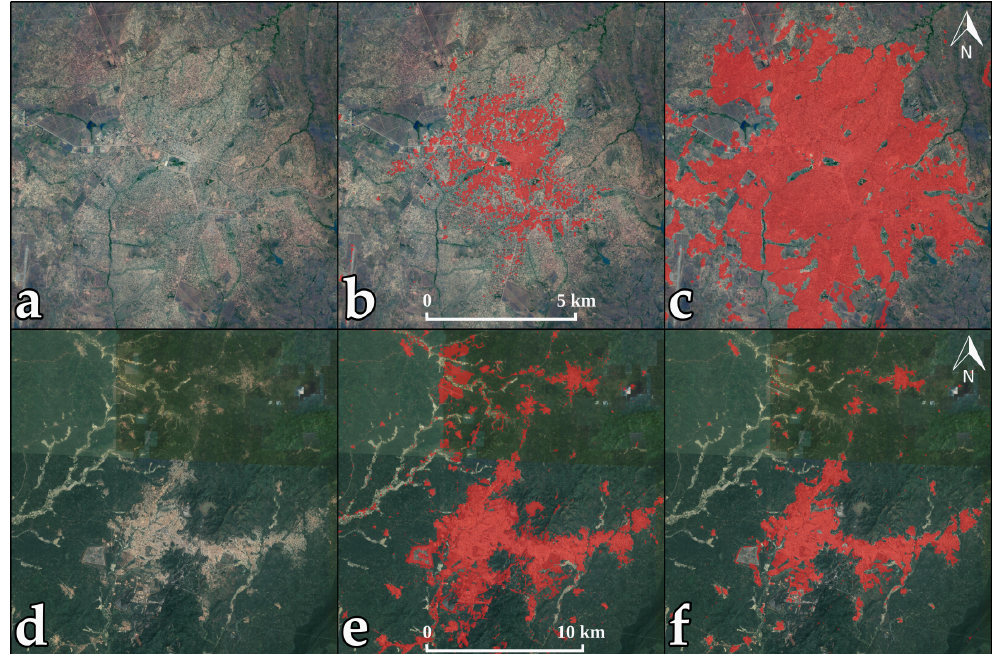
Figure 7. Comparison with the Global Human Settlement Layer (GHSL) in Chimoio, Mozambique and Obuasi, Ghana: ( a ) Aerial view of Chimoio, courtesy of Google Earth; ( b ) GHSL built-up areas (in red); ( c ) computed built-up areas (in red); ( d ) Aerial view of Obuasi, courtesy of Google Earth; ( e ) GHSL built-up areas (in red); (f) computed built-up areas (in